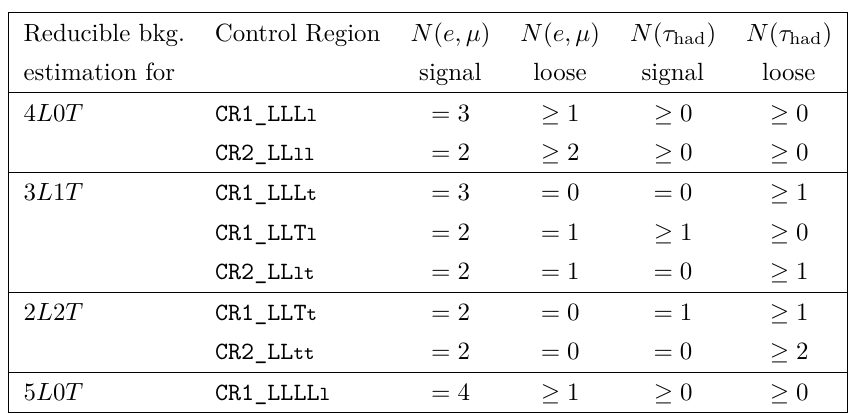
Table 6. Reducible background control region definitions where “ L ” and “ T ” denote signal light leptons and τ , while “ l ” and “ t ” denote loose light leptons and τ . Loose leptons are preselected had had leptons surviving overlap removal that do not pass signal lepton requirements. Additional selections for b -tagged jets, Z veto/requirement, E miss , and m are applied to match a given signal or eff T validation